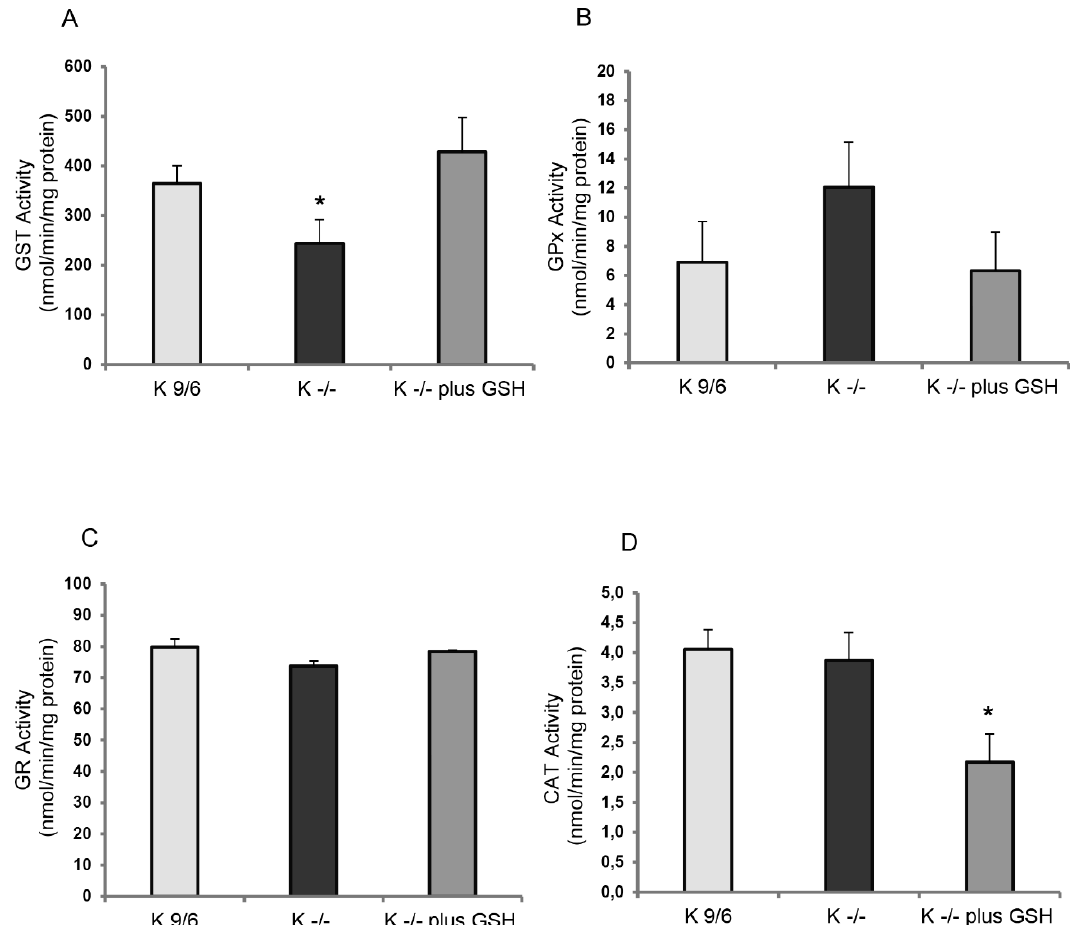
Figure 3. KRIT1 loss-of-function affects the activity of GSH-dependent antioxidant enzymes. Glutathione-S-transferase (GST) ( A ), glutathione peroxidase (GPX) ( B ), glutathione reductase (GR) ( C ), and catalase (CAT) activity ( D ) in K 9/6 and K − / − cells left untreated or treated for 4 h with 5 mM GSH encapsulated within liposomes was measured by specific enzymatic assays, as described in Materials and Methods. Results are reported as mean values ± S.D. of six different experiments. Asterisks above histogram bars indicate significant differences ( p ≤ 0.05) between groups of means (post hoc comparison).